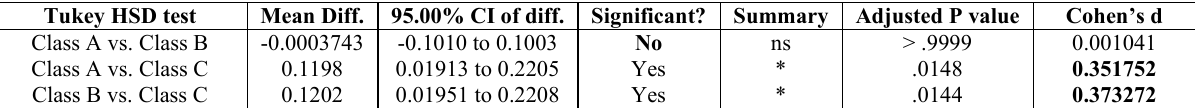
* The mean difference is significant at the .05 level Table 5. Tukey's multiple comparisons test and Cohen’s d effect